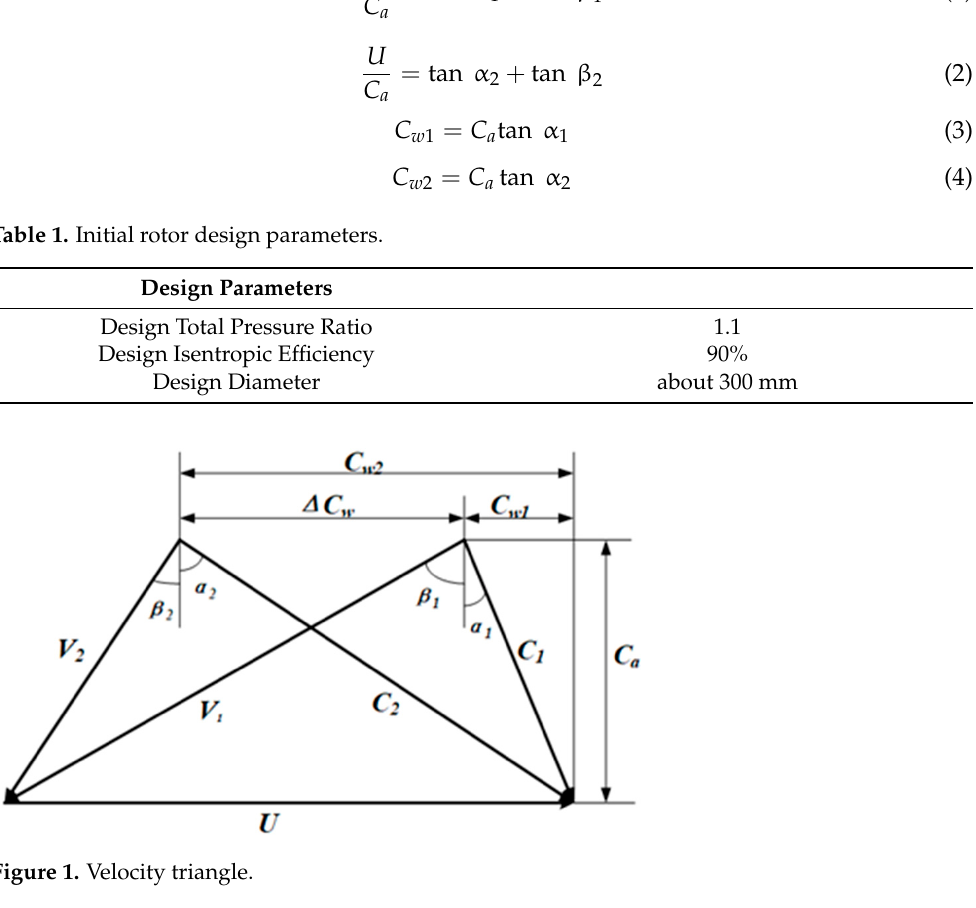
Table 1. Initial rotor design parameters.